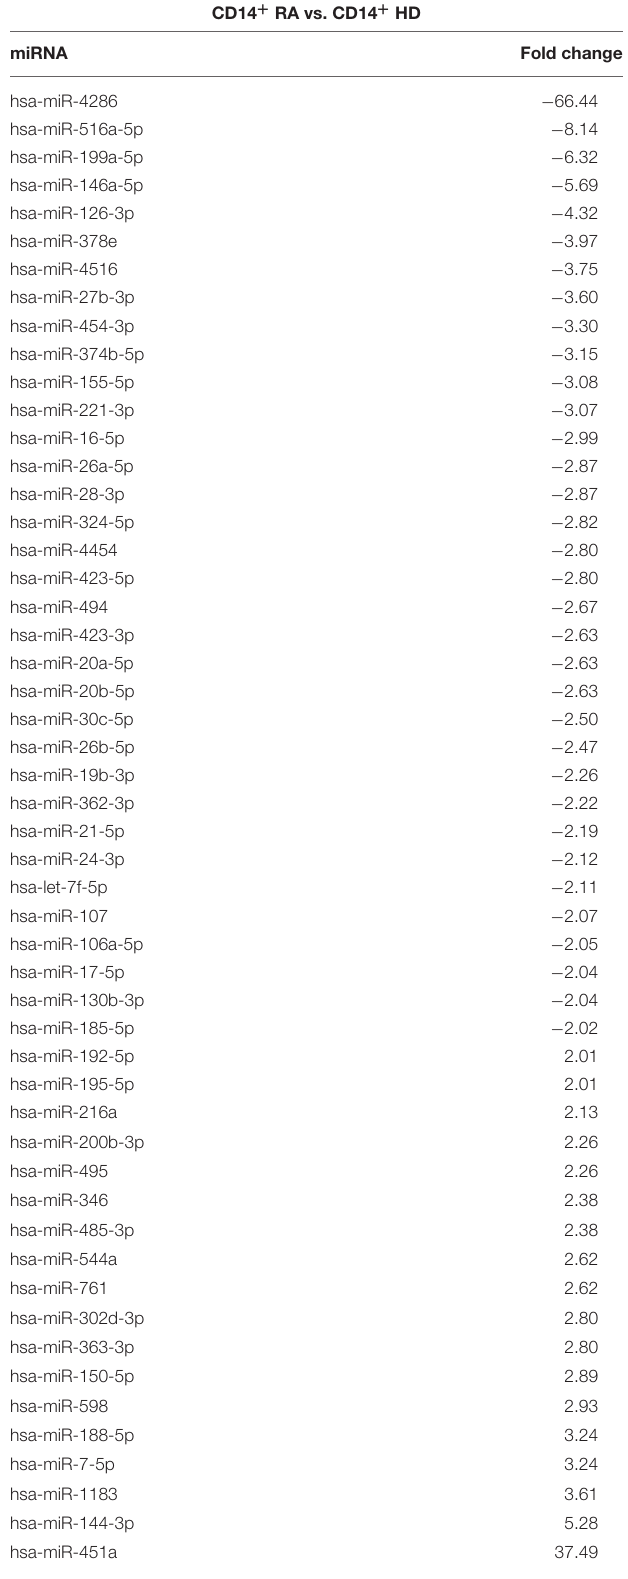
TABLE 2 | MicroRNA expression profile of CD14 + monocytes from Rheumatoid Arthritis patients vs. CD14 + monocytes from healthy donors. CD14 + RA vs. CD14 +